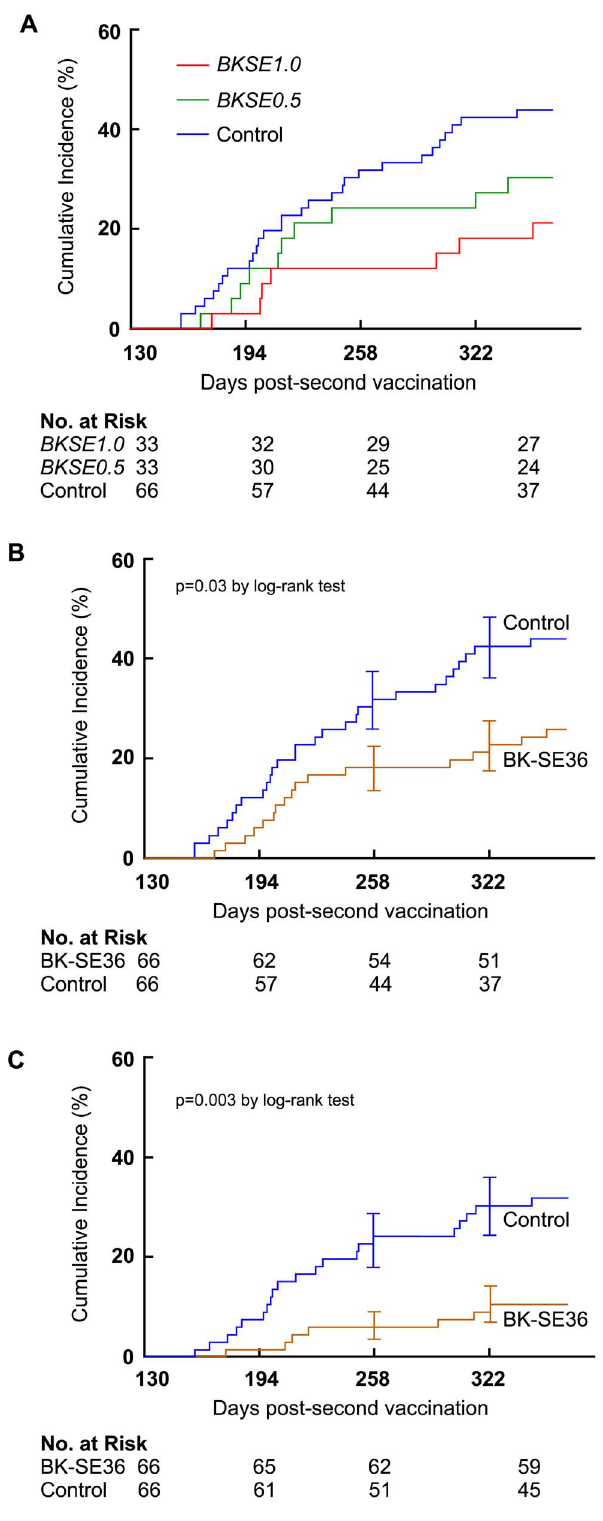
Figure 3. Kaplan-Meier curves of falciparum malaria episodes in 6 to 20-year old, 130–365 days post-second vaccination. Incidence of first (or only) high parasitemia ( $ 5000 parasites/ m L) episodes. The control group consisted of both placebo (vaccinated with saline) and subjects with no intervention. (A) According to vaccine group. Log rank test detected significant difference between control vs. BKSE1.0 (Chi square 4.92, p =0.03) but not vs. BKSE0.5 (Chi square